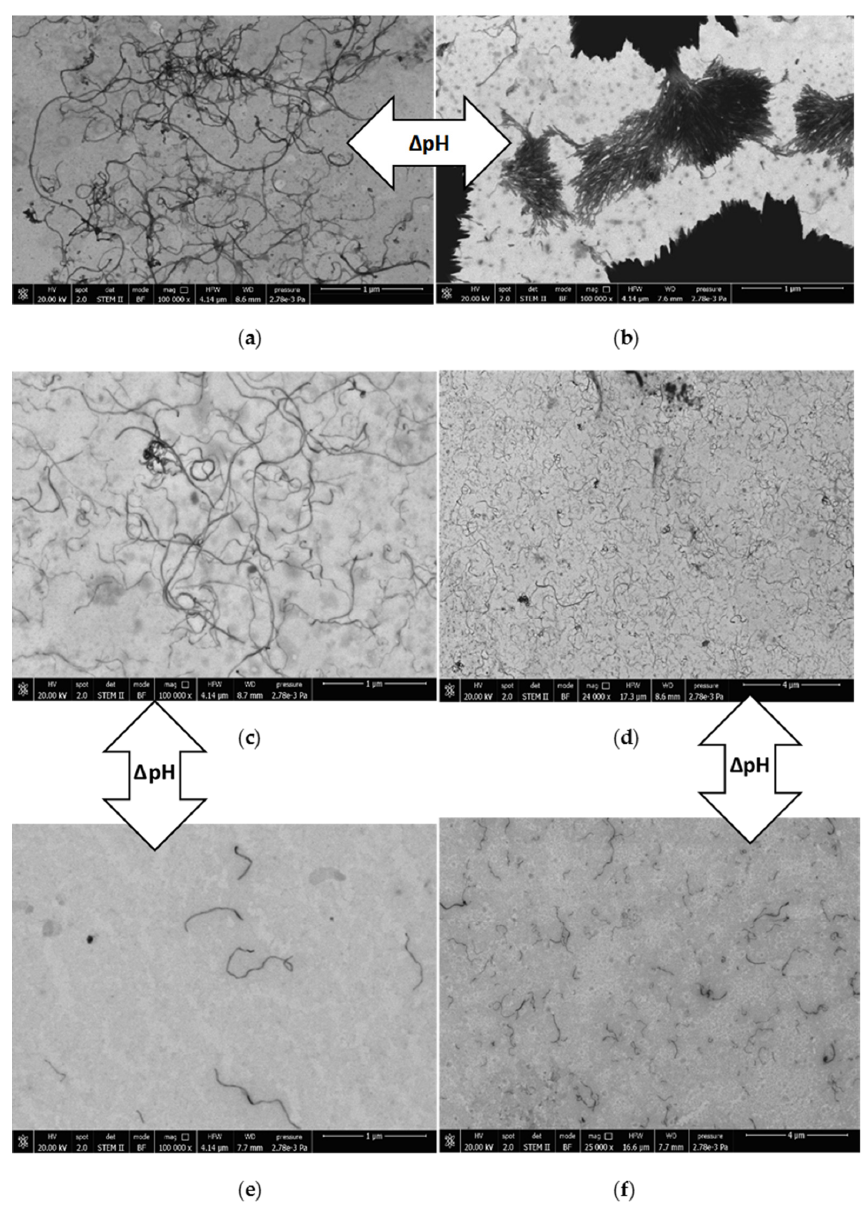
Figure 7. Field emission scanning electron micrographs of ( a ) PS 26 PAA 226 pH 5, ( b ) PS 26 PAA 226 pH 9.5, ( c ) and ( d ) PS 26 PAA 580 pH 5, ( e ) and ( f ) PS 26 PAA 580 pH 9.5.